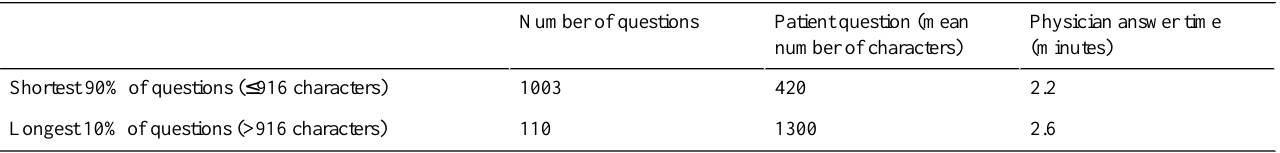
Table 5. Time physicians spent answering the longest 10% of